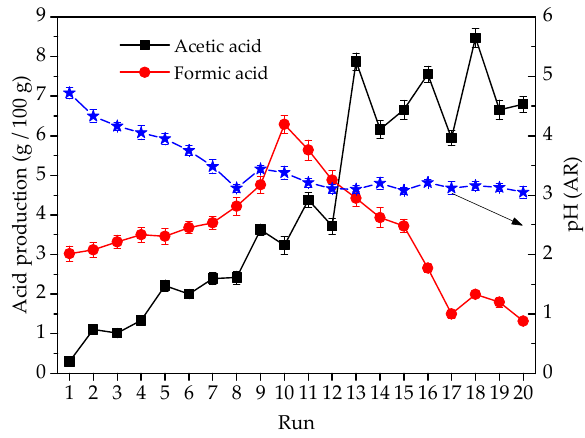
Figure 7. Effect of 1 × 10 − 5 mol/L FeCl 2 pretreatment on acid production. Figure 7. E ff ect of 1 × 10 − 5 mol / L FeCl